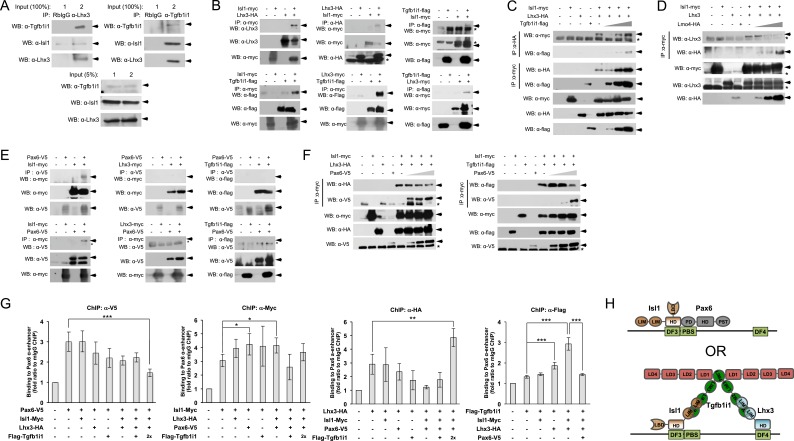
Pax6 and Tgfb1i1 antagonistically regulate Isl1-Lhx3 complex formation.(A) Interactions between endogenous Isl1, Lhx3, and Tgfb1i1 in P7 mouse retinas measured by reciprocal co-immunoprecipitation (co-IP) and subsequent Western blotting (WB) with the indicated antibodies. P7 mouse retinal cell lysates were divided into two input tubes (1 and 2) in prior to the co-IP with indicated antibodies and subsequent WB detection of co-immunoprecipitated proteins. 5% of input cell lysates were used to compare the relative amount of the proteins in the retinal cell lysates used for co-IP. (B) Interactions between epitope-tagged Lhx3 and Isl1, Lhx3 and Tgfb1i1, and Isl1 and Tgfb1i1 in HEK293T cells were determined by co-IP and WB. The successful expression of each transfected cDNA was determined by WB for each protein in cell lysates (50 μg/lane; 5% of the co-IP input) with the corresponding epitope-tag antibodies. Arrows indicate specific WB bands, and asterisks indicate non-specific bands. (C and D) The effects of Tgfb1i1 and Lmo4 on Isl1-Lhx3 complex formation in HEK293T cells. Triangles denote increasing amounts of each DNA construct (1 μg, 2 μg, and 4 μg). Interaction between Pax6 and LIM domain proteins (E) and effect of Pax6 on LIM domain protein complex formation (F) in HEK293T cells were also examined by co-IP and WB analyses. (G) Reciprocal effects of LIM domain proteins and Pax6 on the binding to human PAX6 α-enhancer sequence in the transfected HEK293T cells were measured by qPCR amplification of α-enhancer sequences in DNA fragments isolated by ChIP with the indicated epitope tag-specific antibodies. Relative enrichment of each protein on the α-enhancer was determined by comparing the qPCR value of the transfected samples with those produced by antibodies bind non-specifically to the enhancer element in untransfected HEK293T cells. Error bars indicate STD (n > 5); *p<0.05, **p<0.01, ***p<0.001. (H) Schematic model depicting the binding of the Pax6-Isl1 and Isl1-Tgfb1i1-Lhx3 complexes to the Pax6 α-enhancer element. HD, homeodomain; LBD, LIM-binding domain; LD, leucine-rich domain; PD, paired domain.DOI:
http://dx.doi.org/10.7554/eLife.21303.00810.7554/eLife.21303.009Figure 3—source data 1.Protein-protein interaction between LIM proteins.